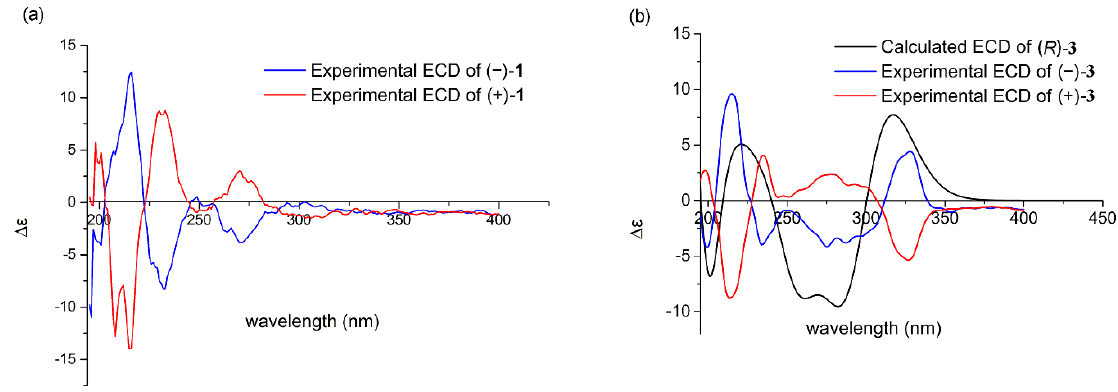
Figure 3. ECD spectrum of compound 1 ( a ) and experimental and calculated ECD spectra of 3 ( b ).